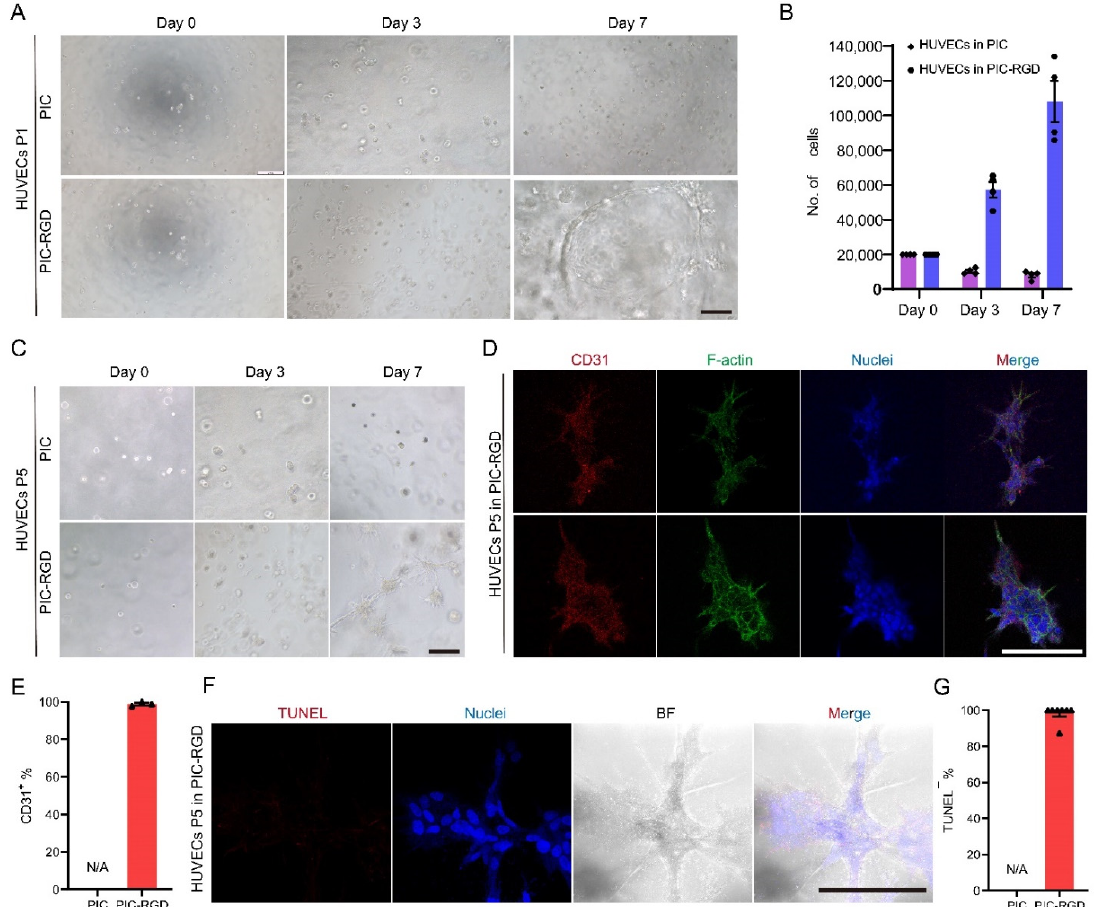
Figure 4. Characterization of HUVECs in PIC hydrogels. ( A ) HUVECs were encapsulated in PIC and PIC-RGD and went through 7 days of culture (scale bar = 200 μ m). ( B ) Number of HUVECs grown in PIC and PIC-RGD for 0, 3, and 7 days. HUVECs did not grow in the PIC gel without RGD, but the proliferation of the PIC -RGD was significant. The error bars represent the standard error of mean of four experiments. ( C ) HUVECs grown in PIC-RGD were subcultured to PIC and PIC-RGD in each generation. The growth characteristic of HUVECs is stable after 5 rounds of passaging in PIC and PIC-RGD (scale bar = 200 µ m). ( D ) Fluorescence staining of P5 HUVECS in PIC-RGD after 7 days of cultures shows good maintenance of phenotype characteristics. CD31: in red, EC maker; phalloidin: in green, stains F-actin; Hoechst33342: in blue, stains cell nuclei (scale bar = 200 µ m). ( E ) Percentage of CD31 positive cells per field of vision. ( F ) TUNEL assay (red) with Hoechst33342 staining (blue, cell nuclei) and bright field image of P5 HUVECs after 7 days in culture in PIC-RGD show few apoptotic cells in spheroids (scale bar = 200 µ m). ( G ) Percentage of TUNEL negative cells per field of vision. For all samples, the PIC and PIC-RGD concentration c = 1 mg mL − 1 and the initial cell density is 200,000 cells mL − 1 . N/A represents not applicable data, since HUVECs do not proliferate in